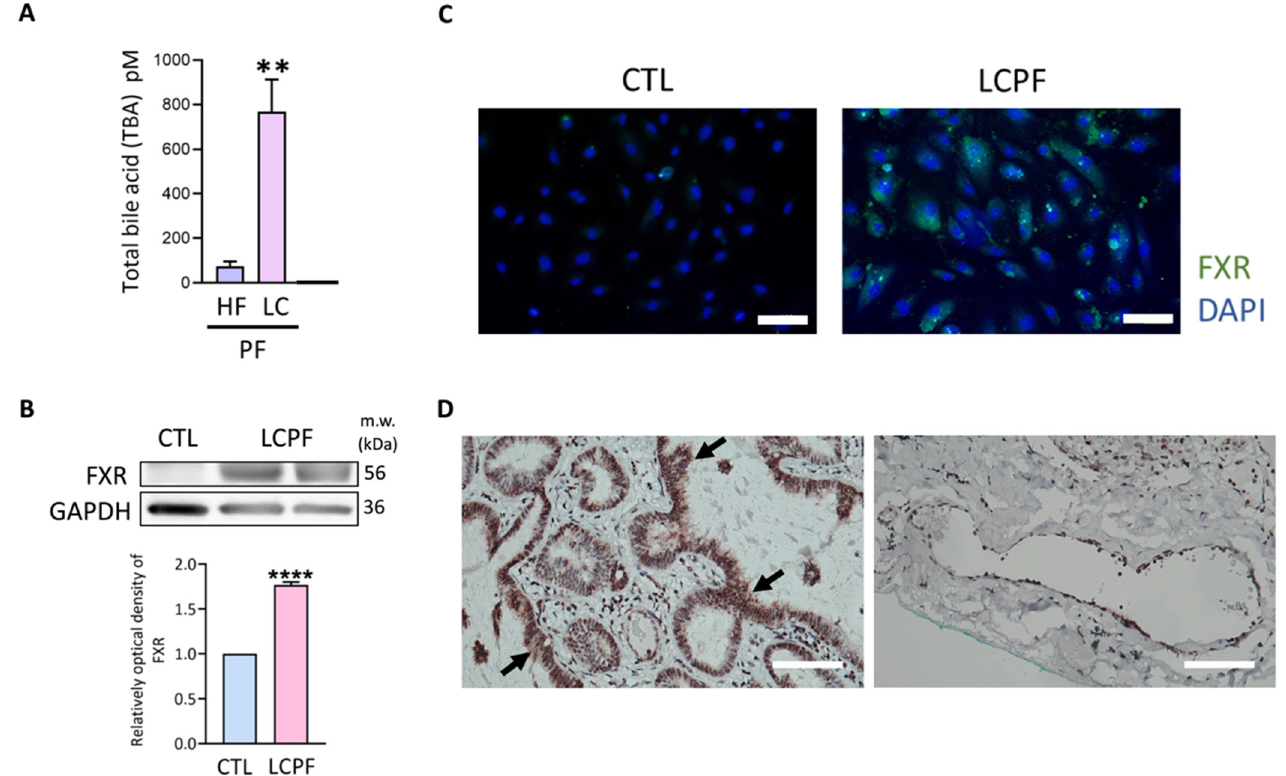
Figure 1. Total bile acid level in pleural fluid and endothelial FXR upregulation by LCPF. ( A ) The total bile acid level was measured by an ELISA kit. Pleural fluid from heart failure patients is referred to as HFPF. The bar graph shows the results of HFPF and LCPF, respectively. Next, HUVECs were incubated with LCPF or a control medium for 24 h. ( B ) FXR protein expression was examined by Western blotting. GAPDH was used as an internal control. ( C ) HUVECs were subjected to immunofluorescence staining for FXR (green) and DAPI (blue). ( D ) Representative images of lung adenocarcinoma (left) and pleural microvessel (right) stained positively for FXR. The magnification is 200 × for ( C ) and 100 × for ( D ), respectively. Scale bar = 100 µ m. The arrow indicates a tumor. ** p < 0.01 and **** p < 0.0001 compared to the control group.